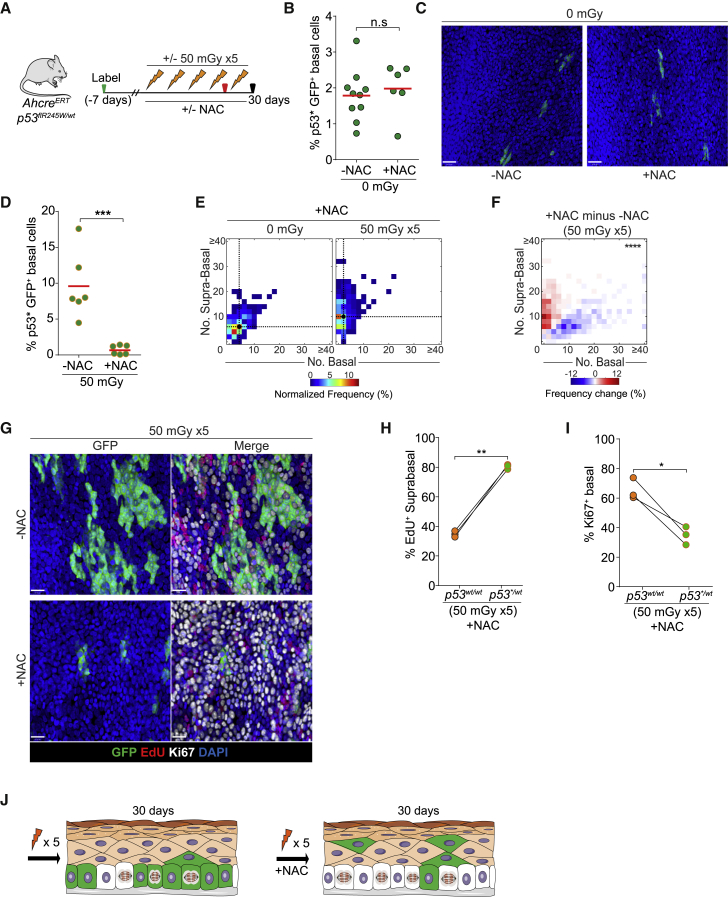
The p53∗/WT Mutant Population Decreases after Combined Antioxidant Treatment and Several LDIR Exposures(A) Experimental protocol. Mice were given the oral antioxidant NAC 7 days after the p53∗/WT allele was induced (green arrow) and kept throughout the experiment. Animals were irradiated with five doses of 50 mGy LDIR over 30 days, commenced with a minimal separation of 3 days between each dose. EdU was injected 1 h prior the last irradiation (red arrow).(B) Percentage of p53∗/WT basal cells in mice treated with or without NAC and non-irradiated. Points show mean values from individual mice. n.s., p > 0.05 by unpaired t test; n = 10 mice (−NAC) and n = 6 mice (+NAC).(C) Top-down views of confocal z stacks of typical EE whole mounts showing p53∗/WT clones (green) under –NAC and +NAC treatments. Basal layer cells are shown. DAPI is shown in blue. Scale bars, 28 μm.(D) Percentage of p53∗/WT basal cells in mice exposed to 50 mGy × 5 and treated with NAC or left untreated. Points show mean values from individual mice. ∗∗∗p < 0.001 (t test), n = 6 mice per condition.(E) Heatmaps showing clone sizes in 0 and 50 mGy × 5 irradiated mice treated with NAC. Black dots and dashed lines indicate geometric median clone size.(F) Frequency change of NAC-treated versus non-treated mice exposed to 50 mGy × 5 LDIR. ∗∗∗∗p < 0.0001 (Peacock’s test), n = 300 clones per condition.(G) Top-down views of confocal z stacks of typical EE whole mounts showing p53∗/WT clones (green), Ki67+ basal cells (white), and EdU+ basal cells (red) after 50 mGy × 5 LDIR without or with NAC treatment. Basal layer cells are shown (DAPI, blue). Scale bars, 40 μm.(H and I) Comparison of p53∗/WT clones with adjacent p53WT/WT EE in the same irradiated animal treated with NAC. Shown are the percentages of EdU+ suprabasal cells (H) and Ki67+ basal cells (I). Points show mean values from 3 mice, and lines link the same animal. ∗∗p < 0.01, ∗p < 0.05 (paired t test).(J) Summary. 30 days after 5 doses of 50 mGy, p53∗/WT clones have expanded through the tissue, replenishing empty space left by p53WT/WT clones when they differentiate. When animals are co-treated with the same 5 doses of 50 mGy plus NAC, p53∗/WT clones are displaced from the tissue by p53WT/WT clones.See also Figures S1 and S6 and Tables S2 and S4.